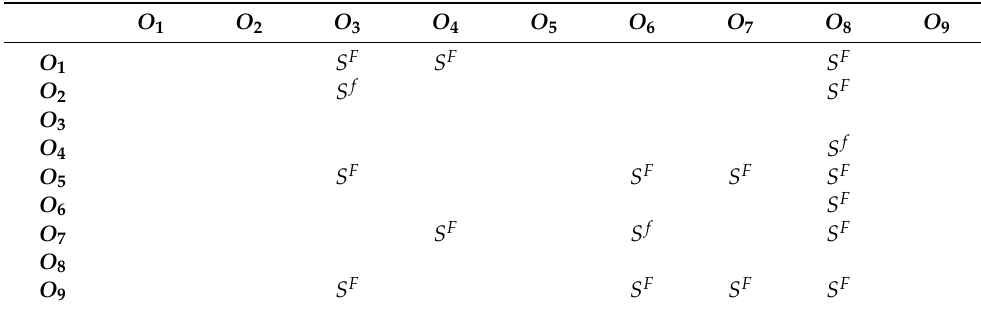
Figure 3. Distances for qualitative criterion performance for all alternative pairs. ( a ) Distances in criterion performance for CoP. ( b ) Distances in criterion performance for QoSD. ( c ) Distances in criterion performance for DoCRNL. ( d ) Distances in criterion performance for UoC. ( e ) Distances in criterion performance for DoCA Table 17. Strong and weak outranking relationships.